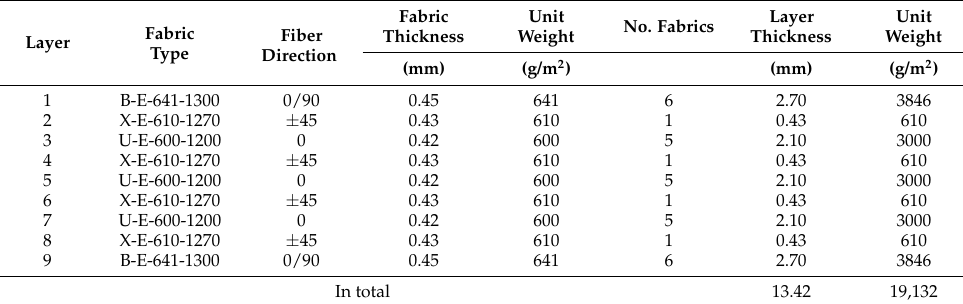
Table 2. Structure of target face